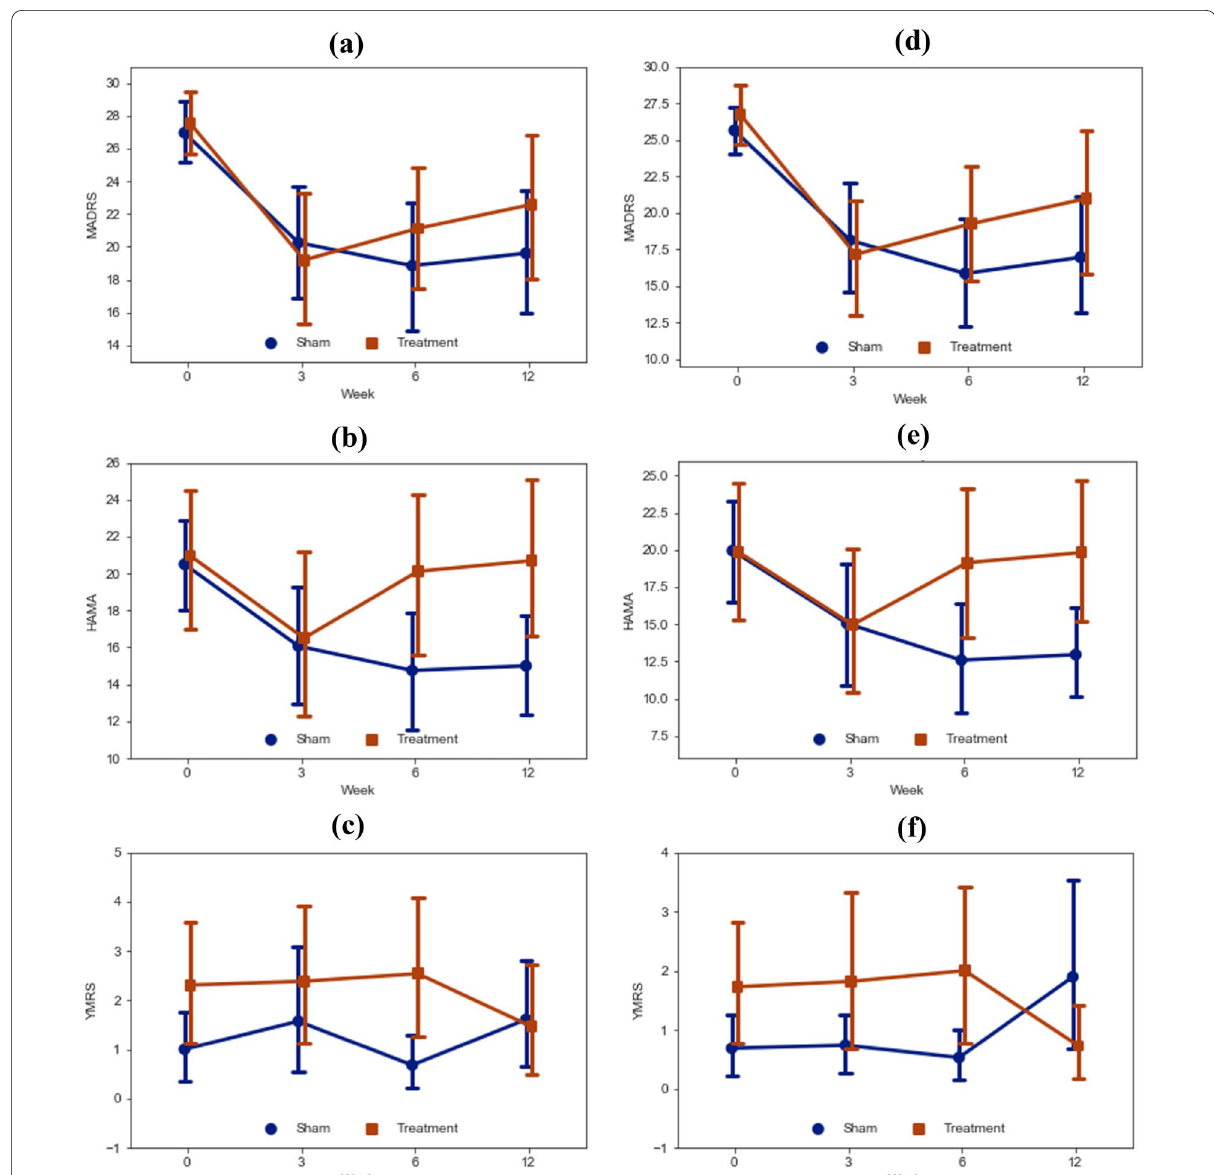
Fig. 1 Marginal means of MADRS, YMRS and HAMA across assessment timepoints. MADRS Montgomery–Åsberg Depression Rating Scale, HAMA Hamilton Anxiety Rating Scale, YMRS Young Mania Rating Scale. a – c Intention-to-treat. d – f